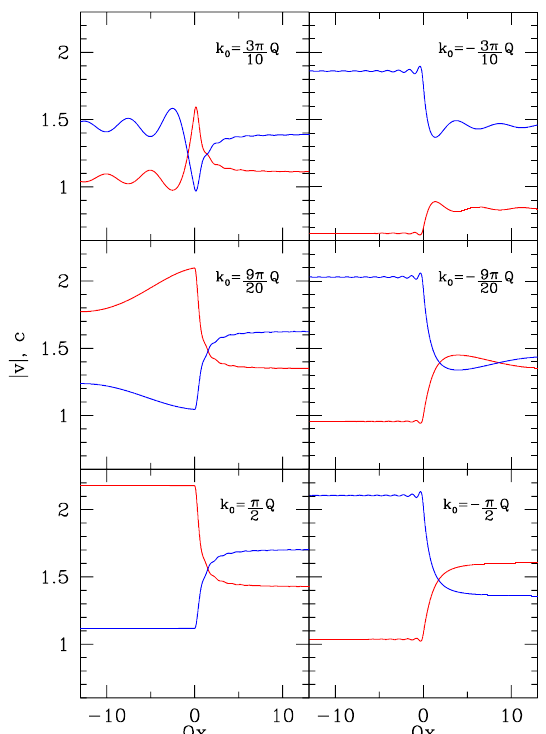
Figure 3. Absolute value of the fluid velocity (red) and of the sound speed (blue) in the stationary Q and several values of k 0 . Left panels correspond to a left moving states corresponding to k F = π 2 fluid, right panels to right moving fluid (i.e., against the step). Velocities are in unit of ¯ hQ